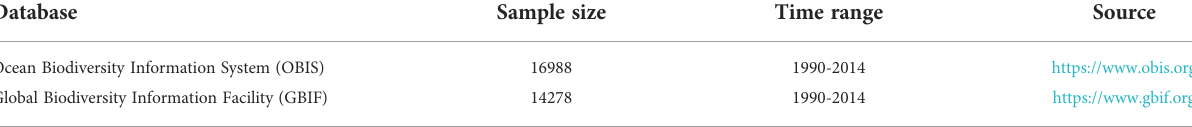
TABLE 1 Sample size, time range and source of the initially selected common minke whale occurrence